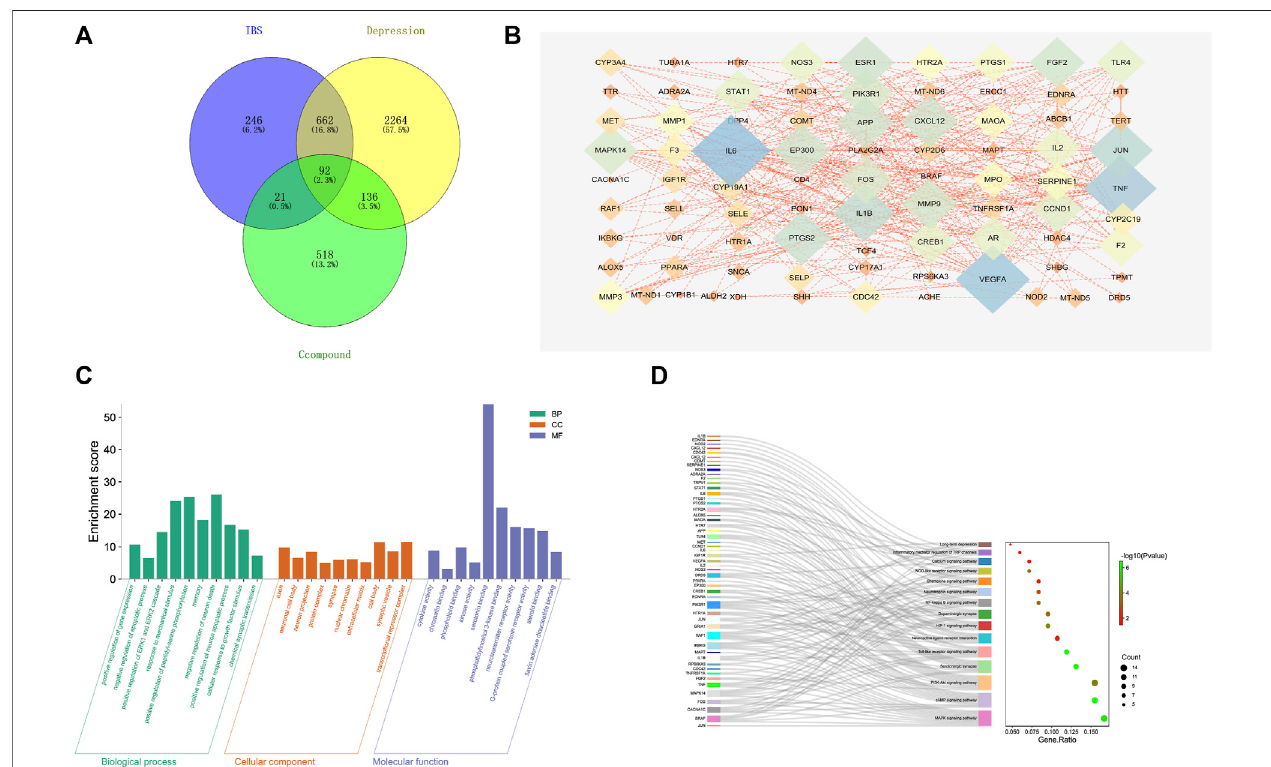
FIGURE 10 | Target network analysis. (A) Venn diagram of intersection of the drug targets and disease proteins. (B) Protein-protein interaction network of target genes. (C) GO terms for the candidate targets of CKF in IBS; the top 10 GO functional categories are shown. (D) KEGG pathway enrichment analysis for the candidate targets of CKF in IBS. The sizes of the circles represent the number of genes and the color represents the signi fi cance ( p